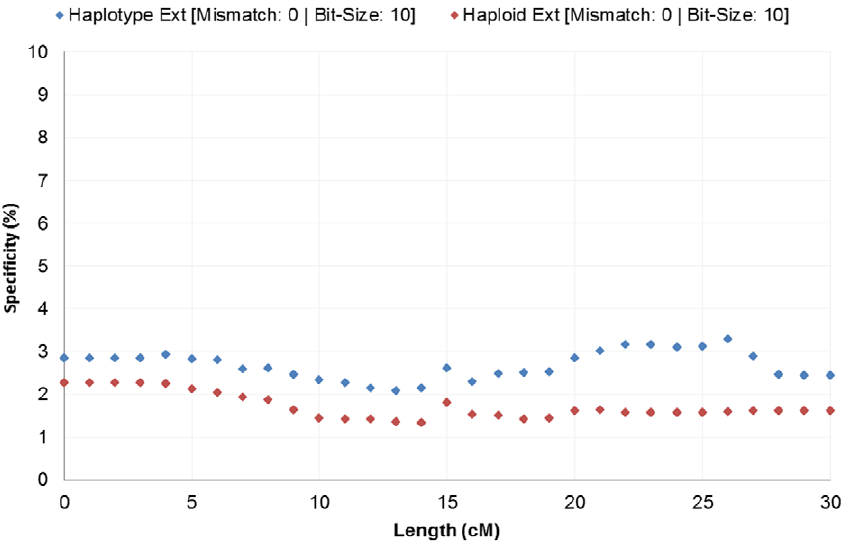
Figure 1. Exome specificity with varying segment length. Exome sequencing IBD data is shown to have low specificity with GWAS IBD data. Even at lengths of 30 cM and with stringent IBD segment generation parameters, the specificity remains low at under 3%.